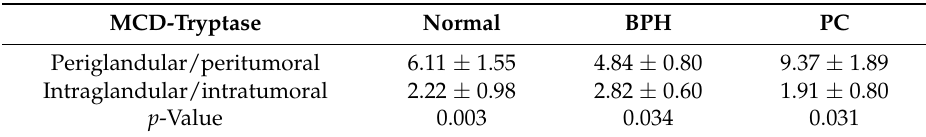
Table 2. Mast cell density (MCD) in periglandular/peritumoral areas versus intraglandular/intratumoral areas based on tryptase immunoexpression. p -Value is significant in all the three groups: normal, benign prostate hyperplasia (BPH) and prostate carcinoma (PC).